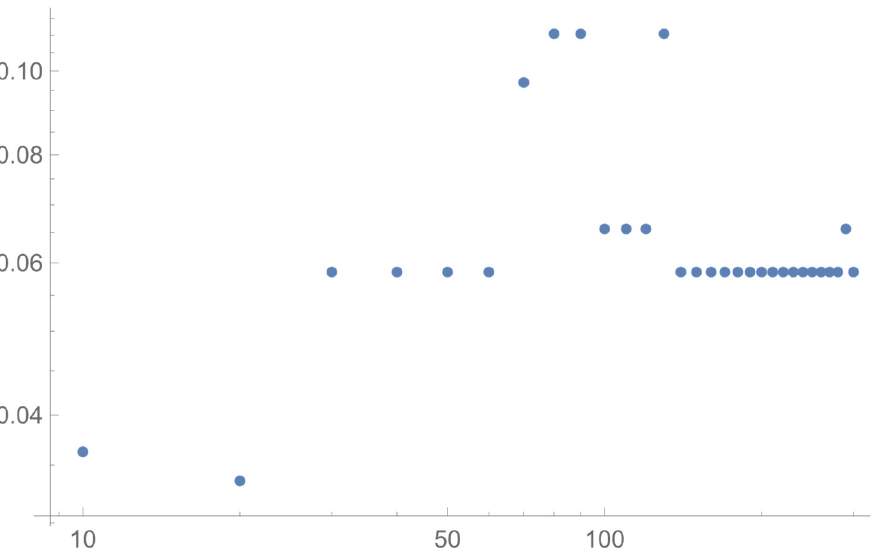
Figure 6. IPOPT performance on standard LSP model-instances, with the proposed starting solution, up to 𝑛 = 300. Difference between the area 𝐴(𝑛) of the optimized polygon and 𝜋 4⁄ .